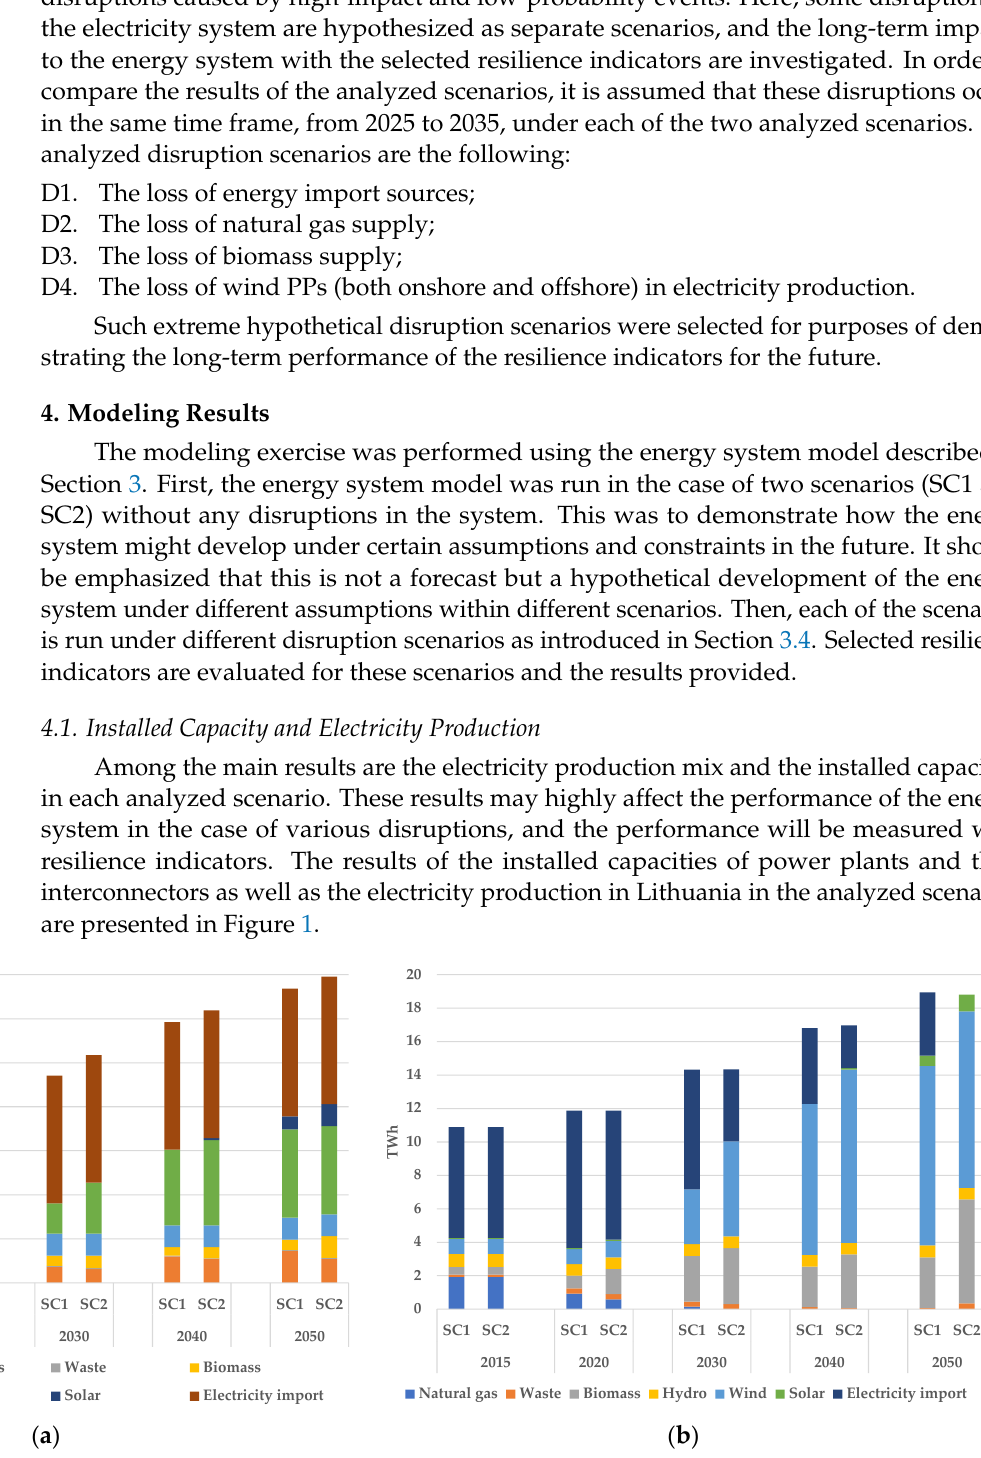
Figure 1. ( a ) Installed capacities of electricity production sources; ( b ) electricity production by different energy